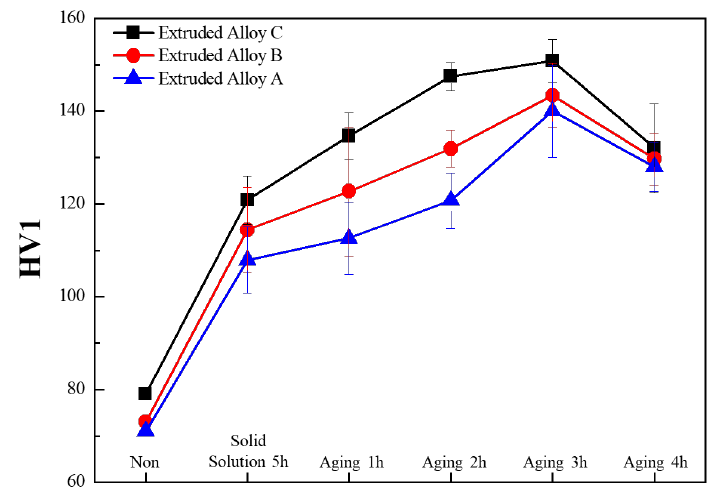
Figure 3. HV1 values of Al-XSi-3Cu-0.6Mg-0.5Fe [X = (A): 10; (B): 12.6; (C): 14] extruded alloys with and without T6 heat treatment.